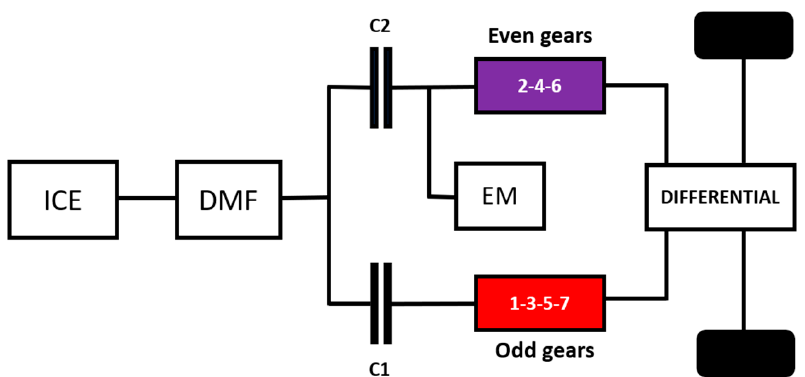
Figure 1. Hybrid dual clutch transmission architecture.